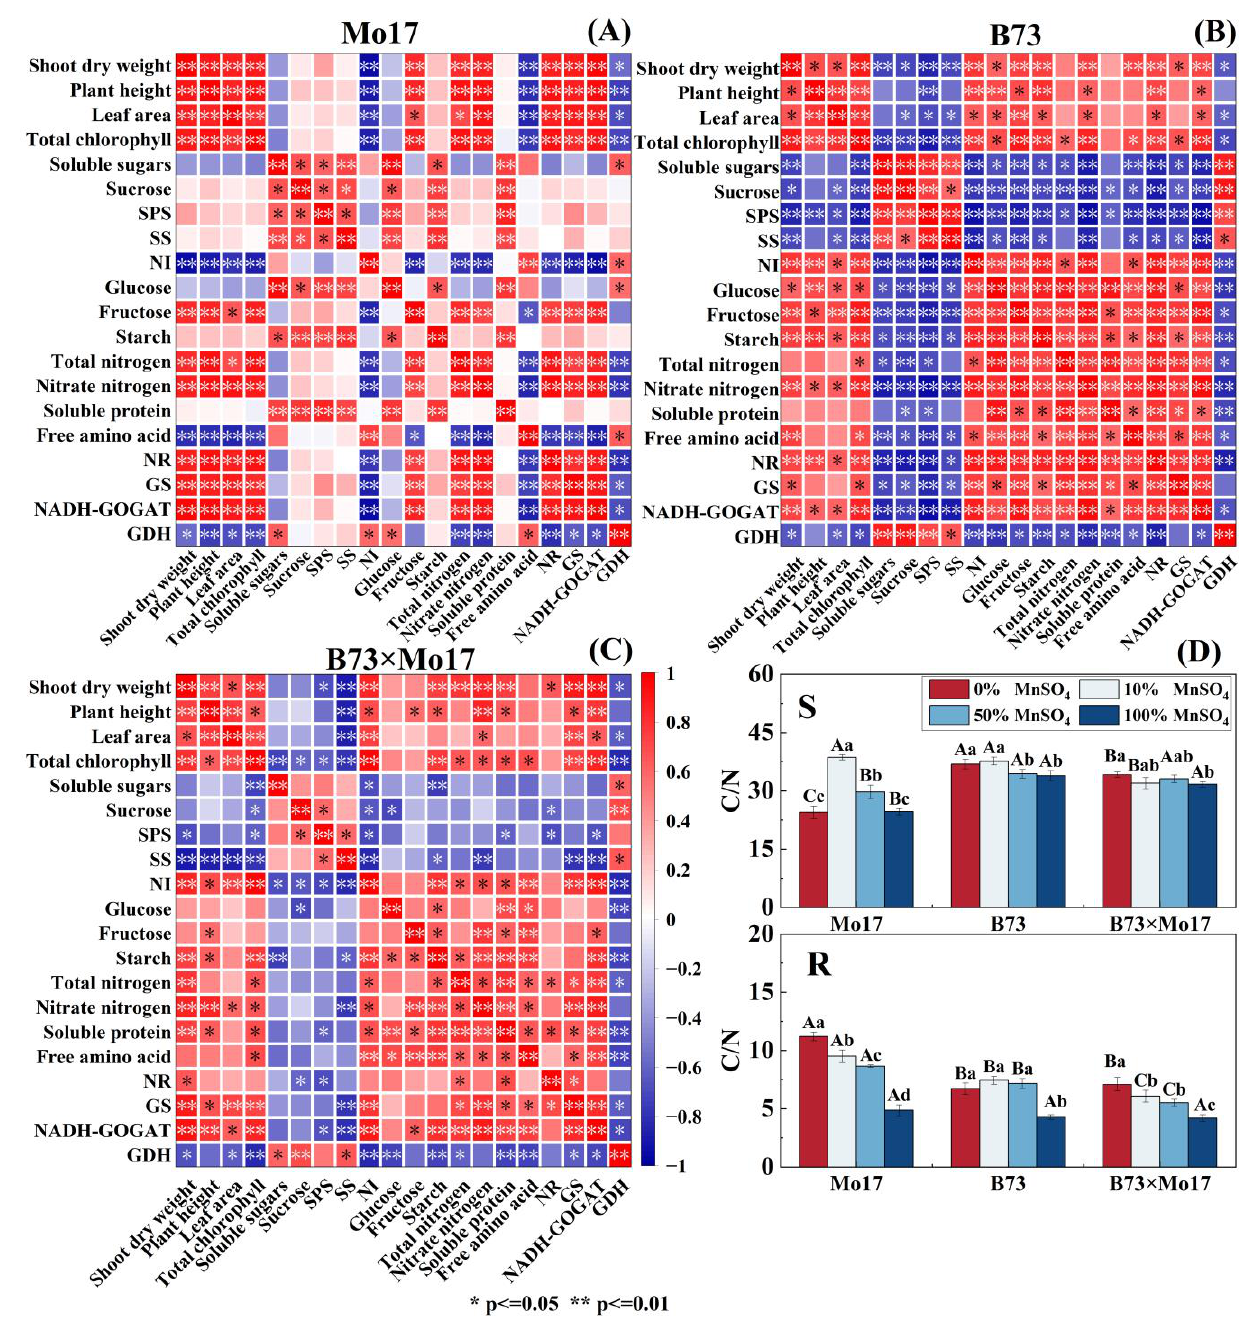
Figure 8. Correlation among dry weight, plant height, leaf area, and carbon and nitrogen metabo-lism in leaves of maize seedlings Mo17 ( A ), B73 ( B ), B73 × Mo17 ( C ) and carbon-to-nitrogen ratio ( D ). According to the LSD test different capital letters: significant difference between varieties ( p < 0.05); different lowercase letters: significant difference between MnSO 4 treatments ( p < 0.05). S rep-resents leaf-related parameters, R indicates root-related parameters.